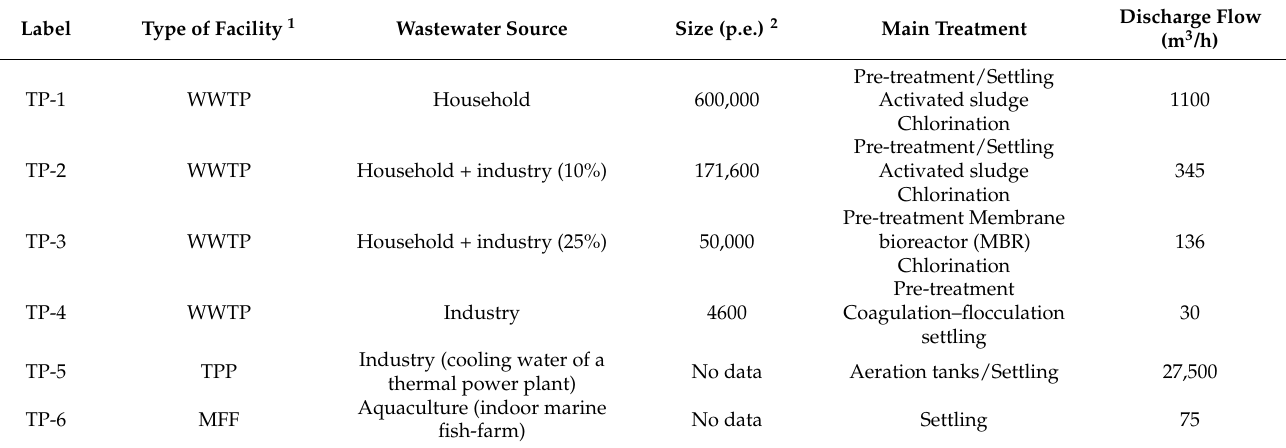
Table 1. Main treatments and characteristics of the sampled